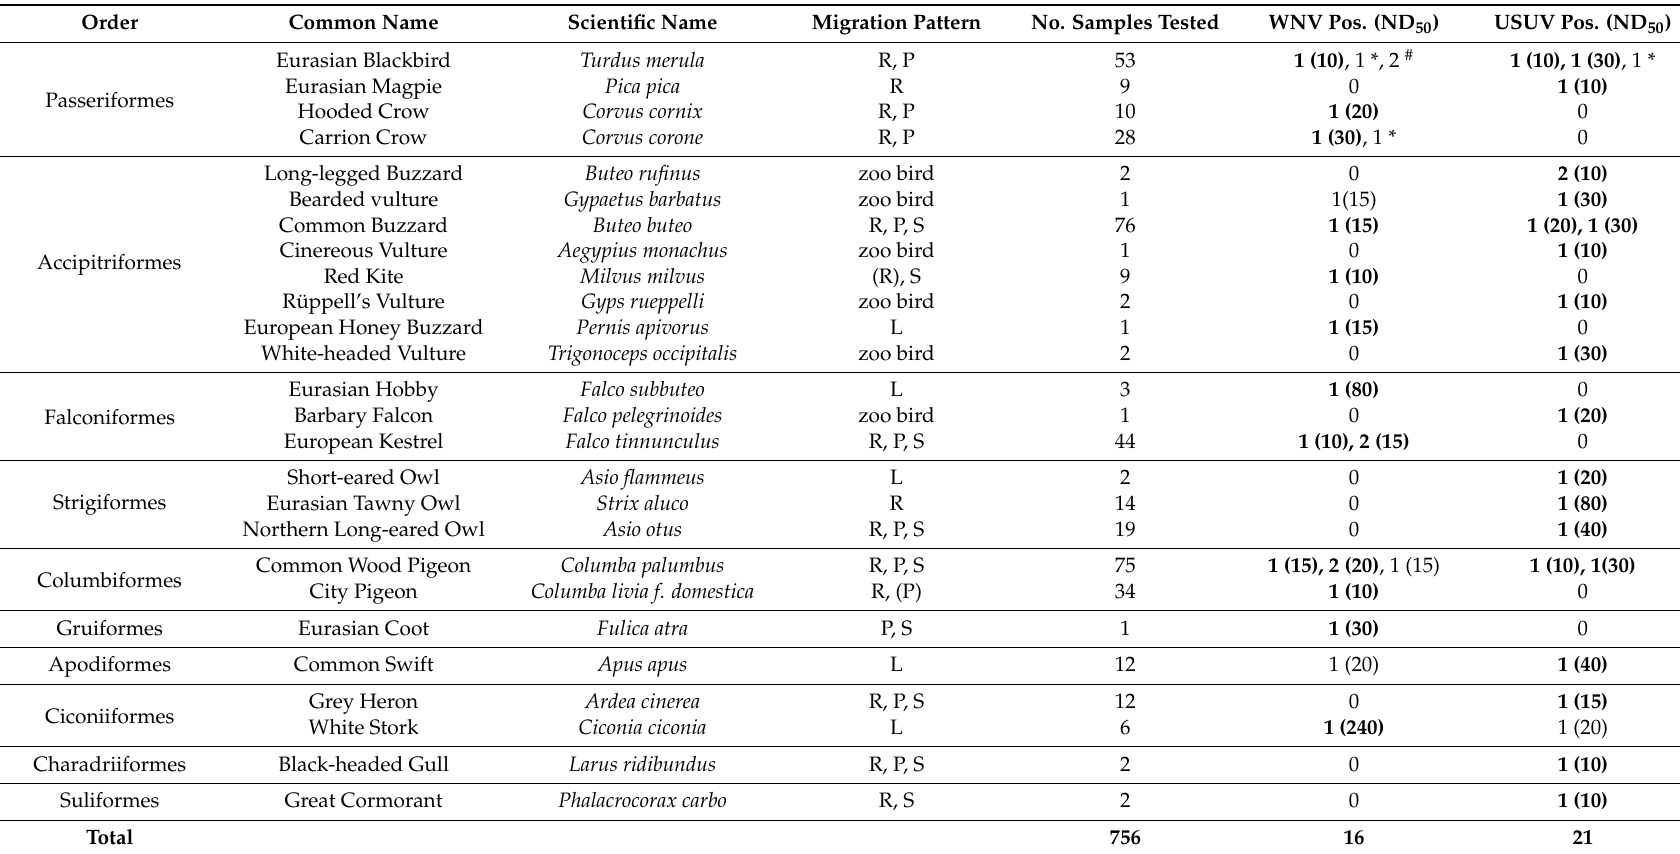
Table 6. WNV and USUV positive neutralization assay results (positives highlighted in bold) from wild bird serum samples in